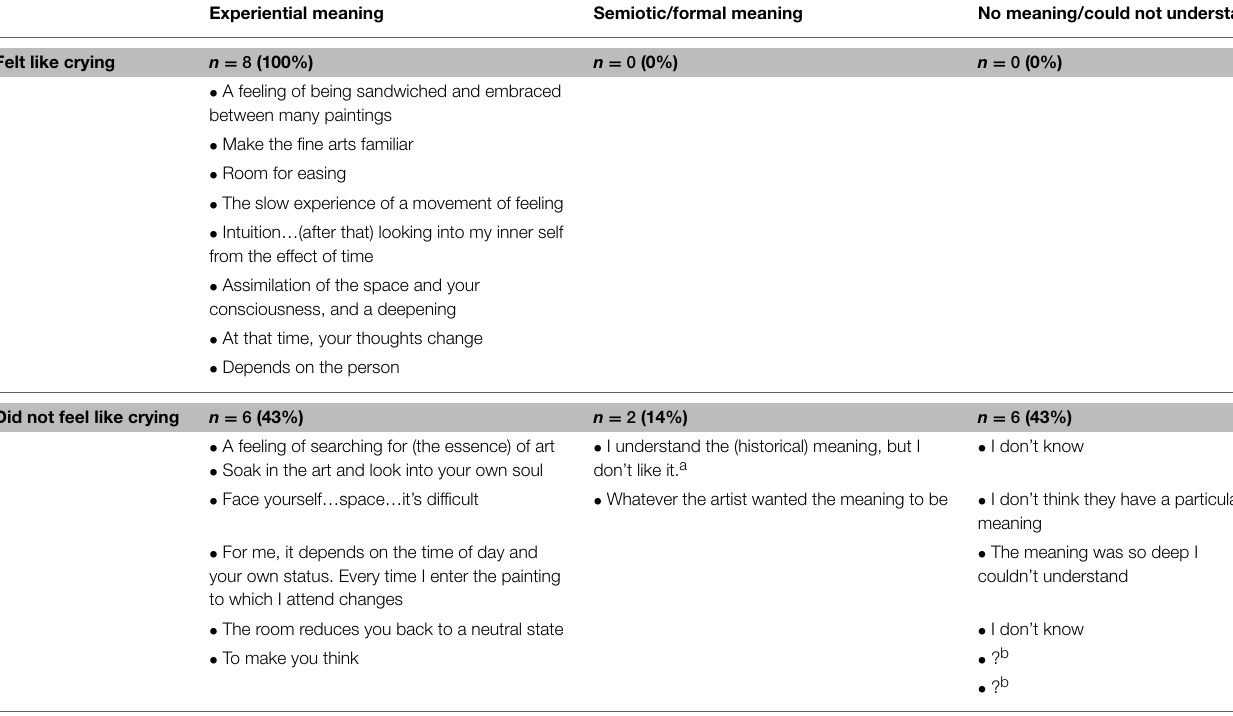
TABLE 6 | Answers to “what was the meaning of the art?” organized by reported feeling like crying and type of meaning appraisal: Rothko Room, Kawamura DIC Museum, Japan. Experiential meaning Semiotic/formal meaning No meaning/could not